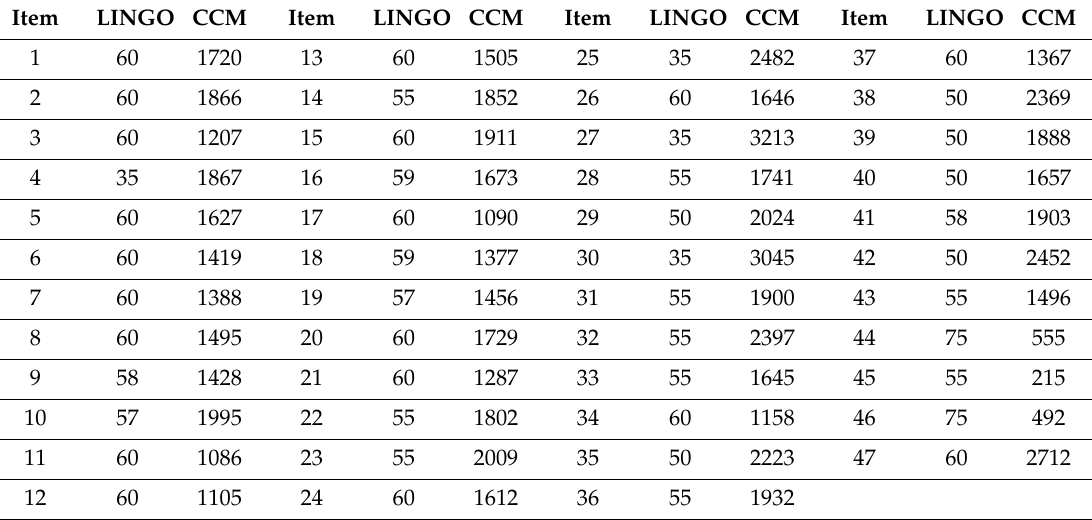
Table 5. The number of iteration for LINGO and the canonical coordinates method (CCM) to find the local optimal